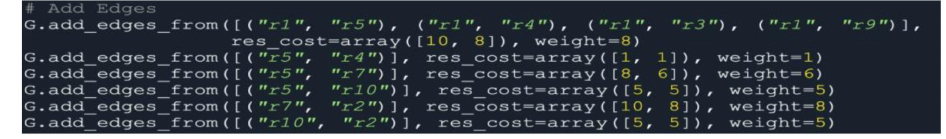
Figure 15. Setting of different weights for each route in the network topology.